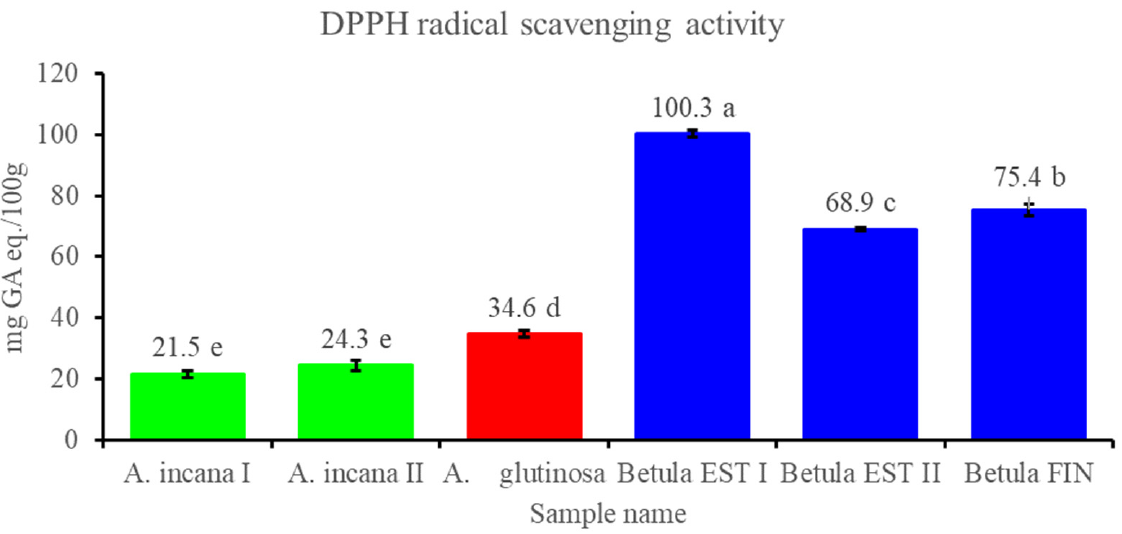
Figure 1. DPPH radical scavenging activity of 80% ethanol extracts from the conks expressed as gallic acid equivalents per 100 g of dry material (mg GA eq./100 g). All values are means, n = 3; mean values within a column with different letters are significantly different at p < 0.05.